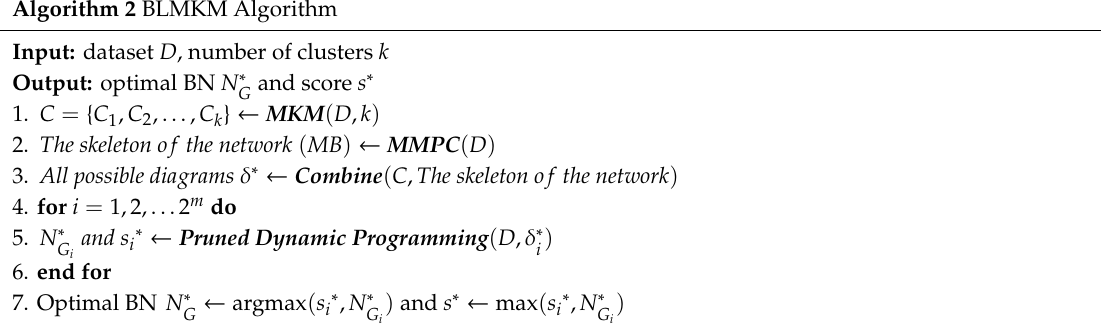
Figure 6. Pruned parent graph of node X 1